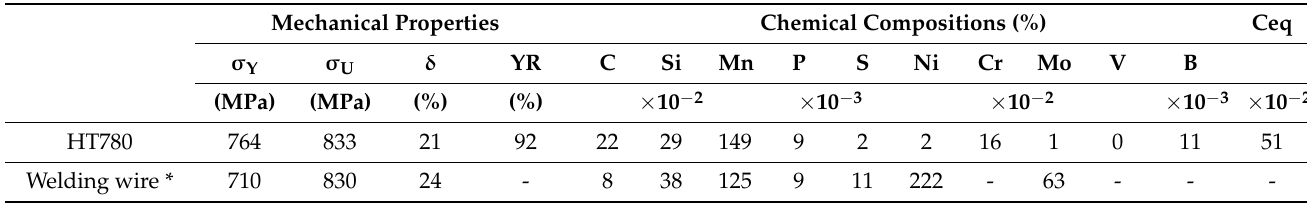
Table 1. Mechanical property and chemical composition.